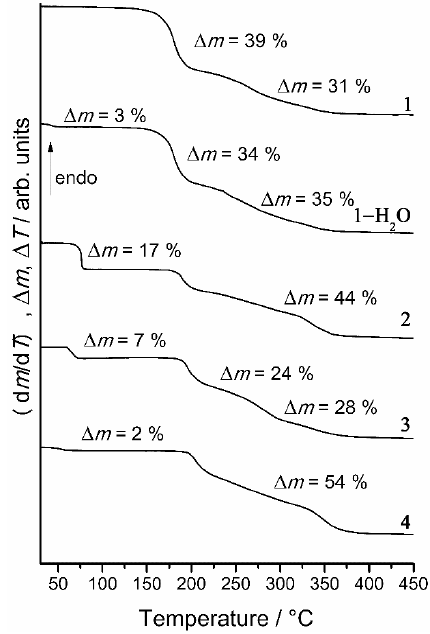
Figure 6. Thermogravimetric curves for compounds 1 , 1-H 2 O , 2, 3 and 4 . Heating rate = 1 °C/min ( 1 , 1-H 2 O , 2 ), and heating rate = 4 °C/min ( 3, 4 ). Given is the mass loss in %.